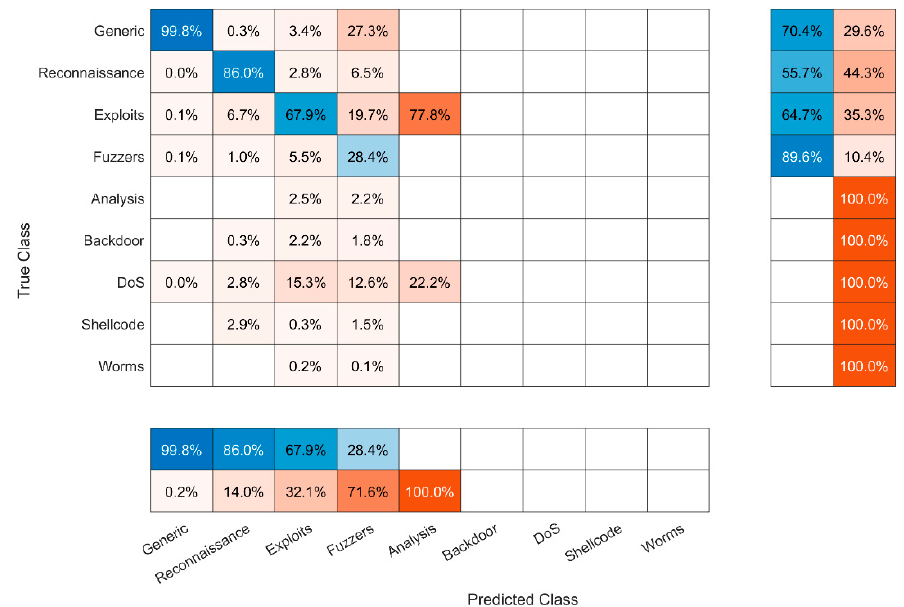
Figure 12. Confusion matrix using ML.NET created model on UNSW-NB15 training dataset for attacks only.